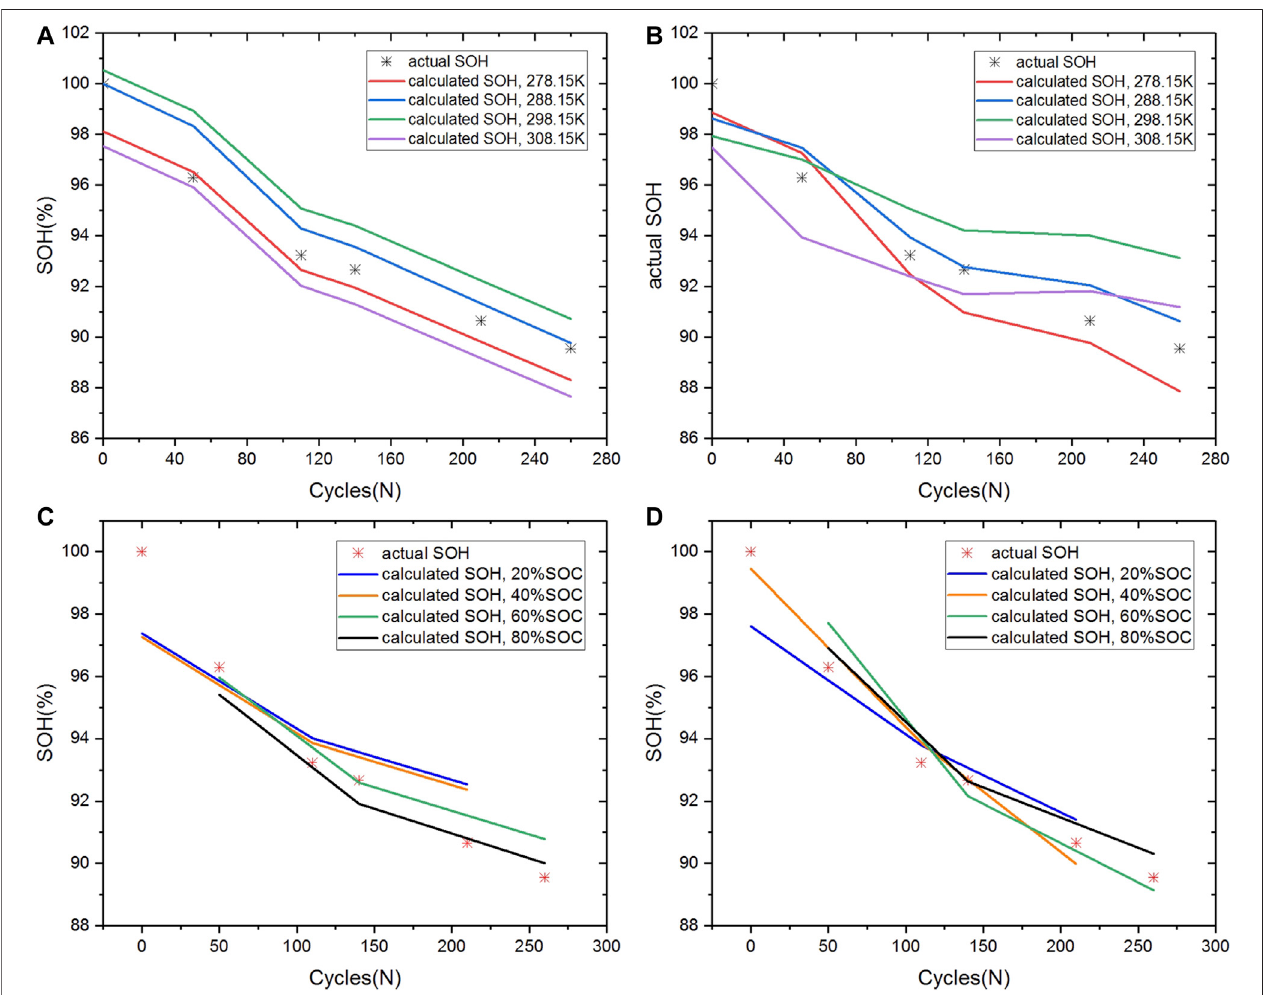
FIGURE 8 | The comparison between the calculated SOH under different temperatures and the actual SOH of Cell four under 50% SOC. (A) Exponential temperature factor. (B) Linear temperature factor; the comparison between the calculated SOH under different SOCs and the actual SOH of Cell 4 at 25 ° C. (C) Exponential SOC factor. (D) Quadratic SOC